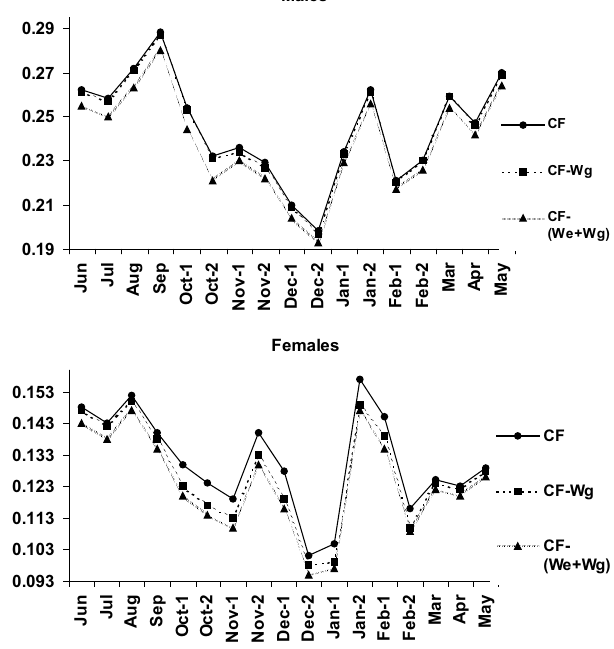
Fig. 3. Monthly distribution of the condition factor (CF) av- erage, condition factor without the gonad weight (CF1) and condition factor without the gonad and stomach weight (CF2) in males and females of Eigenmannia trilineata